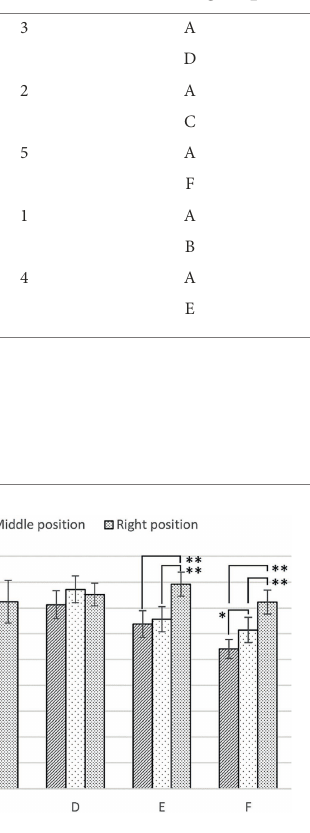
Visual information